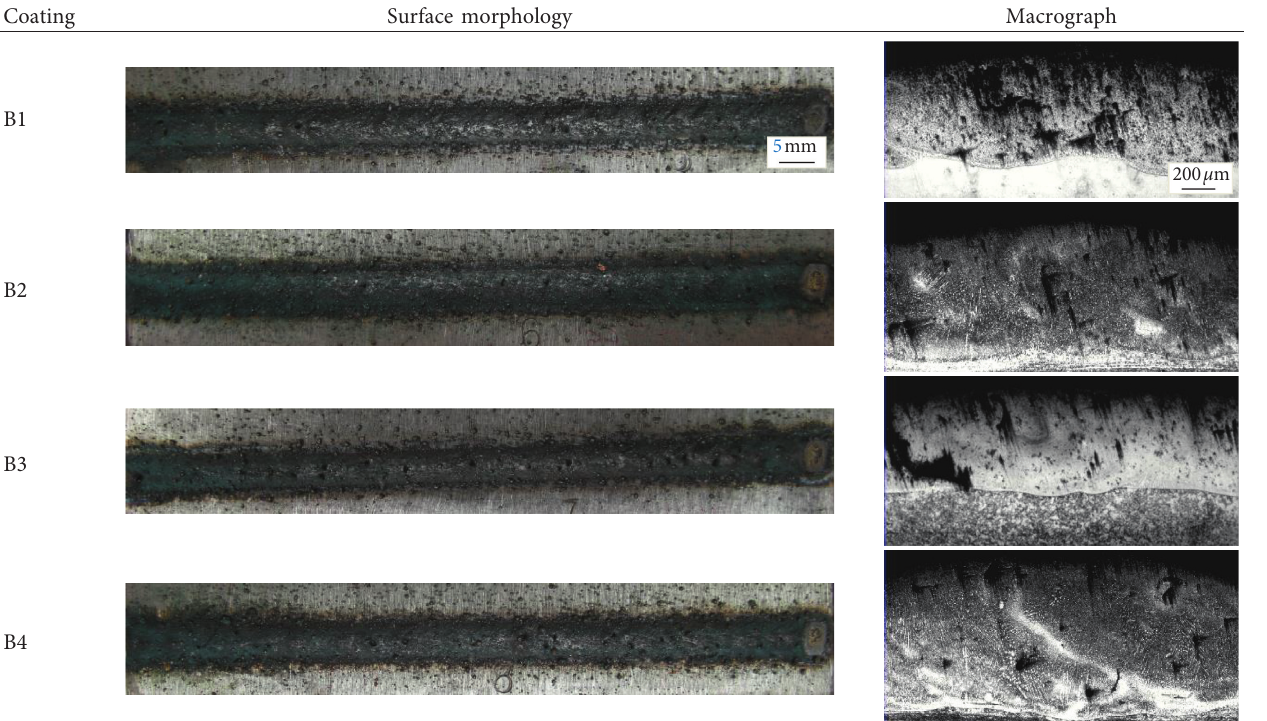
Table 4: The surface morphology and macrograph of the B